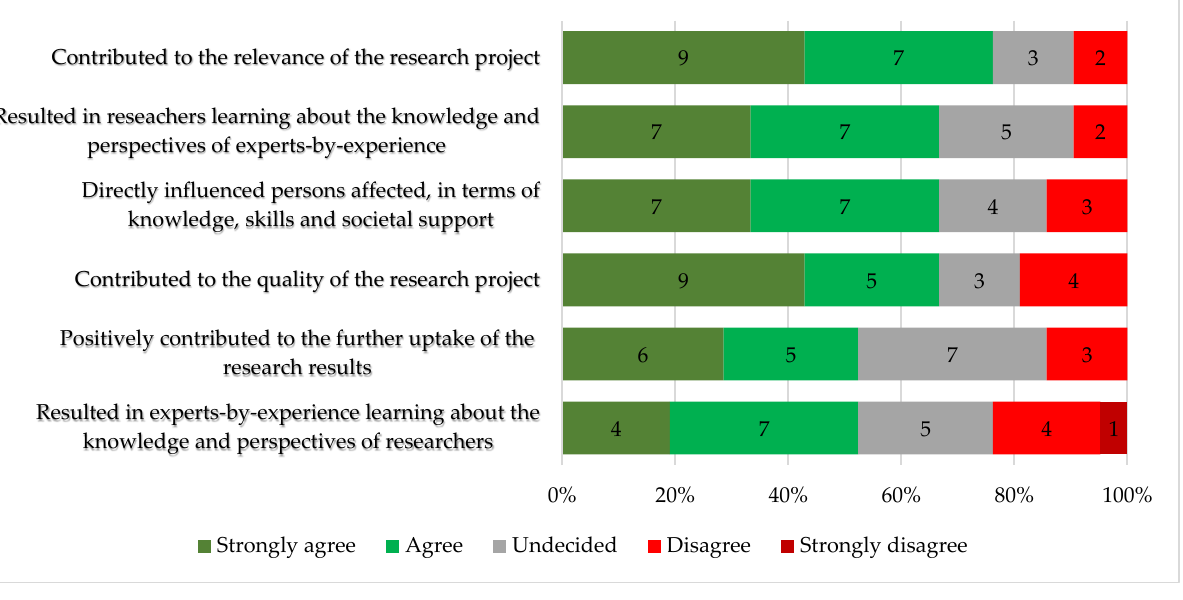
Figure 2. Participants’ perceived degree of agreement regarding statements about their experiences with engagement of experts-by-experience in their